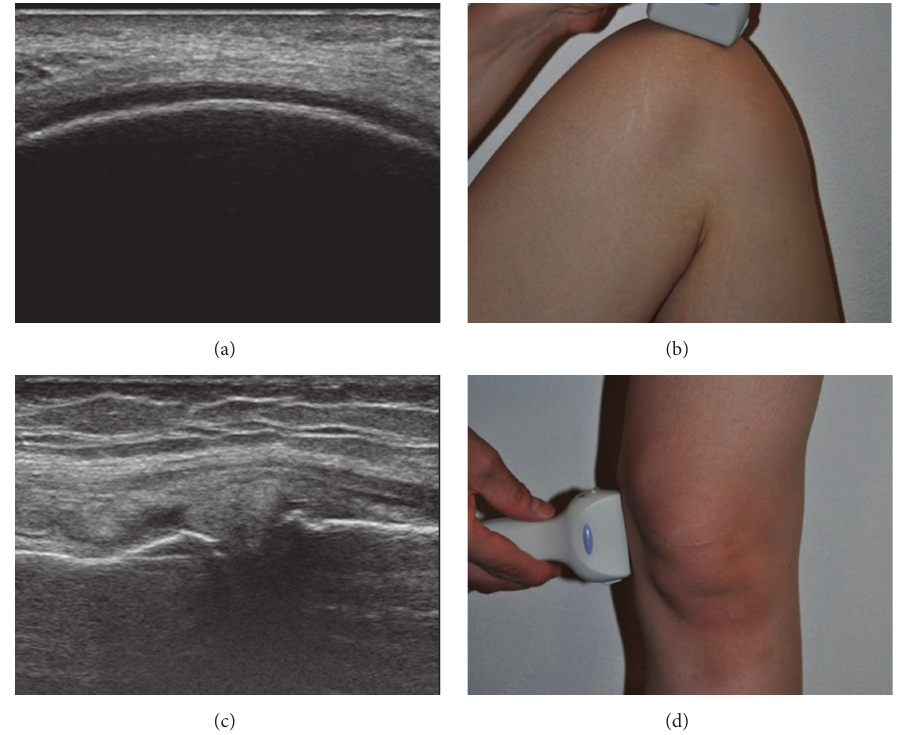
Figure 1: (a) Cartilage thickness of the femoral medial condyle. (b) Depiction of the femoral cartilage by putting the probe on the weight- bearing surface. (c) Radial displacement of the medial meniscus. (d) Depiction of radial displacement by putting the probe on the medial joint